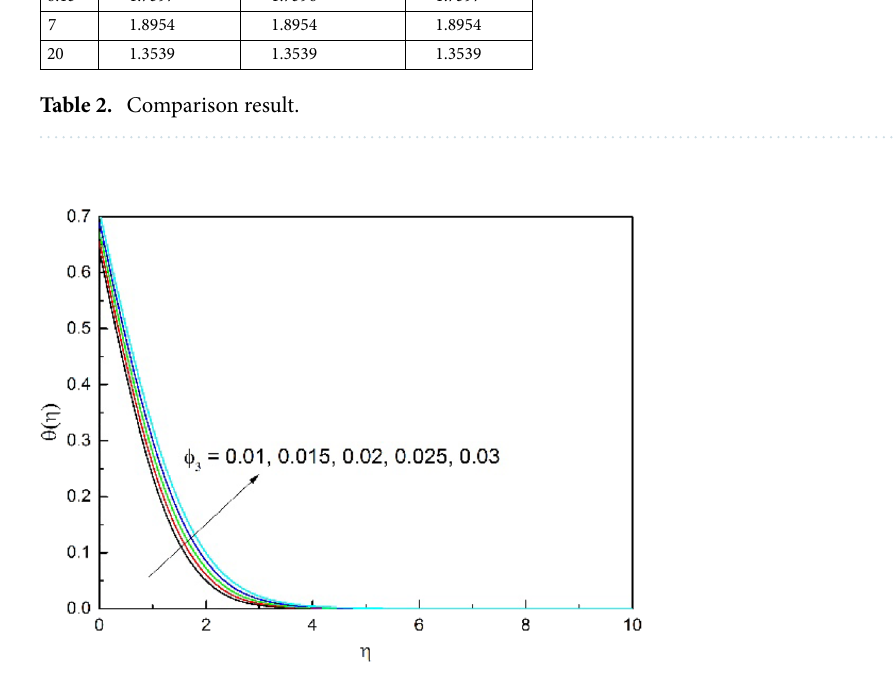
Figure 2. φ 3 on θ(η)